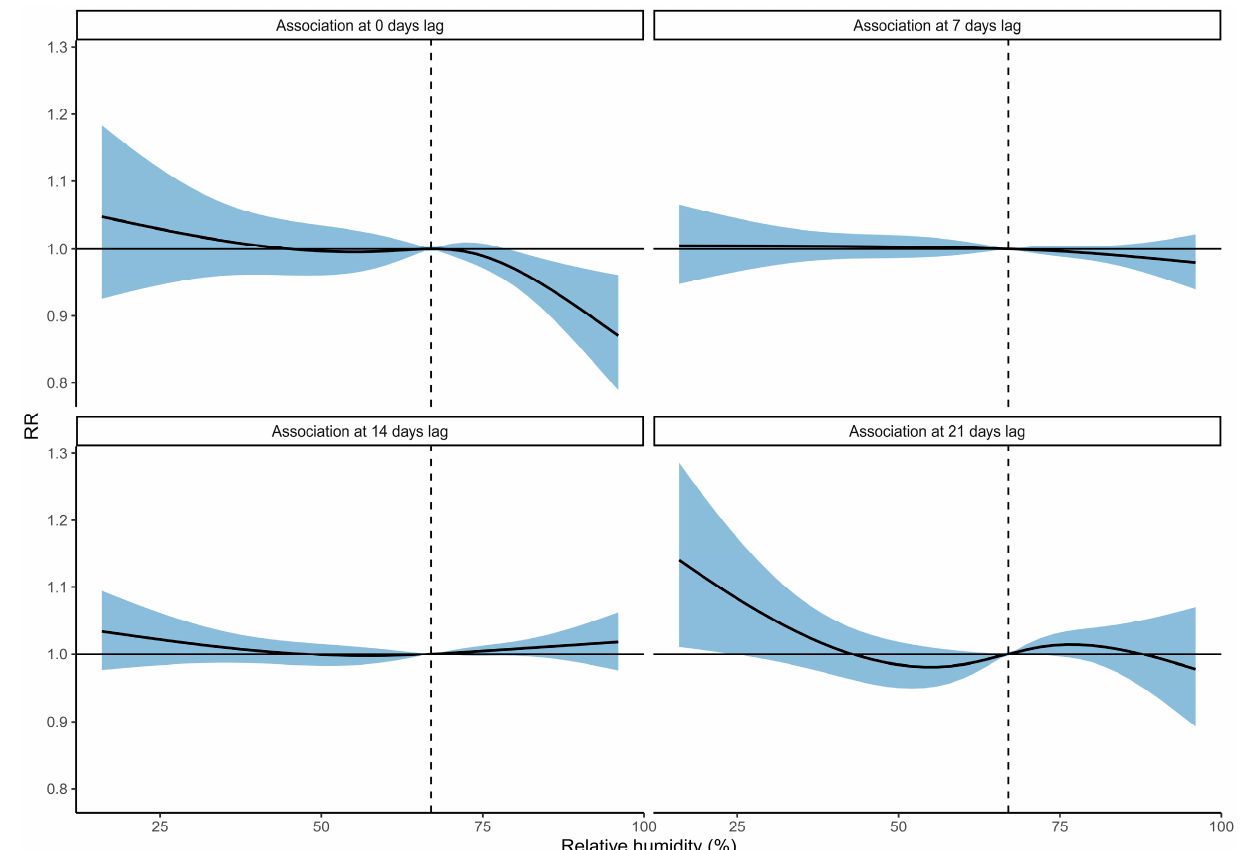
Figure 6. The association between relative humidity and pneumonia hospital admissions at different days of lag. The solid curves are the predicted relative rates (RR), and the shaded regions are the 95%CI. The median relative humidity (67%) is indicated by the dashed vertical line and is used as the reference value against which the RR for other relative humidity values is